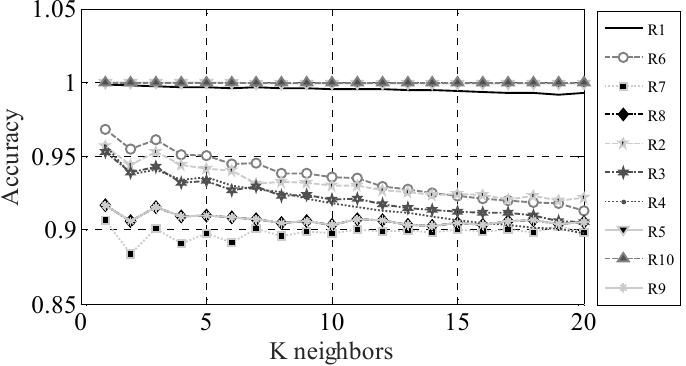
Figure 9. K-nearest neighbors (K-NN) performance in function of adjustment of its hyper- parameters.